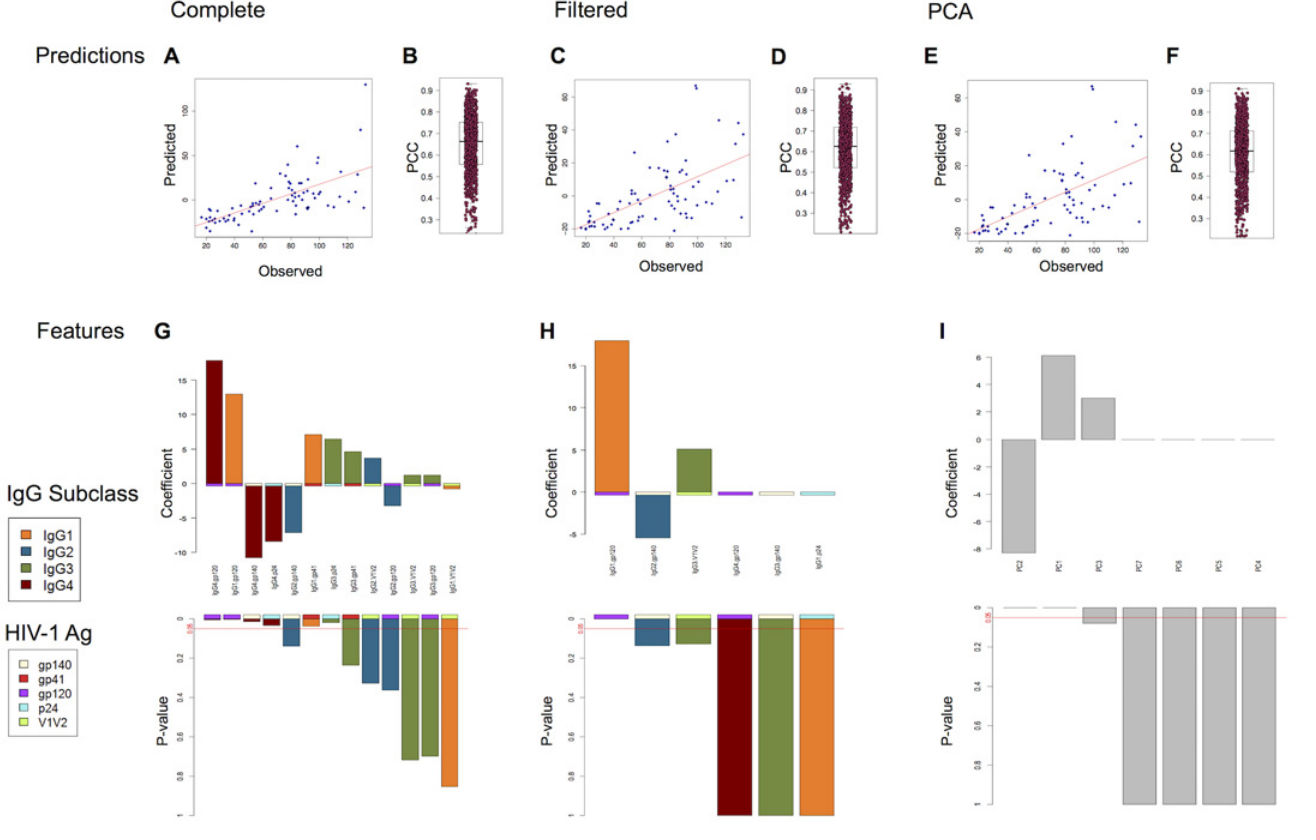
Fig 4. Regression modeling of ADCP from antibody features by Lars. (A,C,E) Representative regression scatterplot based on leave-one-out cross- validation, (B,D,F) PCCs for 200-replicate five-fold cross-validation. (G-I) Coefficients and p-values of the features for a model trained on all subjects. Different input features were used: (A,B,G) the complete set; (C,D,H) the filtered set; (E,F,I) the principal components. Box & whisker plots show the median (thick center line), upper and lower quartiles (box), and 1.5 times the interquartile range (whiskers); all points are also plotted in a jittered stripchart. Colors for the feature coefficients indicate antibody subclass and